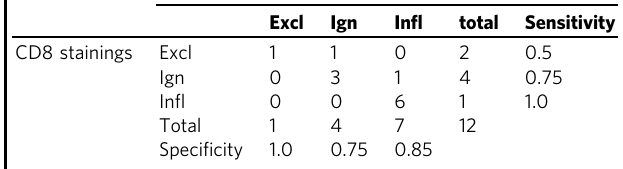
Table 1 for details). We observed signi fi cantly higher frequencies of the excluded (41%) and ignored phenotypes (37%), and decreased frequencies of the in fl amed (21%) phenotypes when metastasized TNBC was compared to primary TNBC. This was not dependent on biopsy sites, which supports the prognostic nature of the